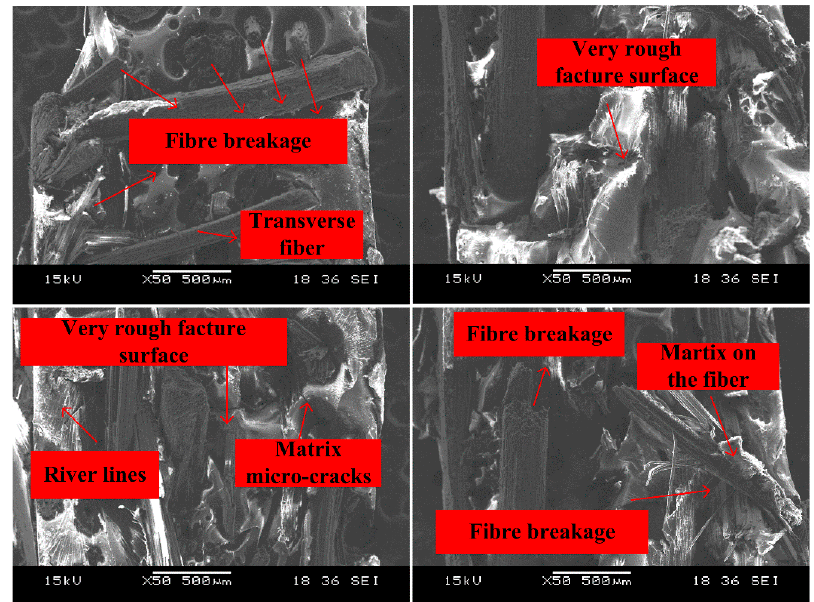
Figure 11. Fracture morphologies of APB under the strain rate of 110/s.